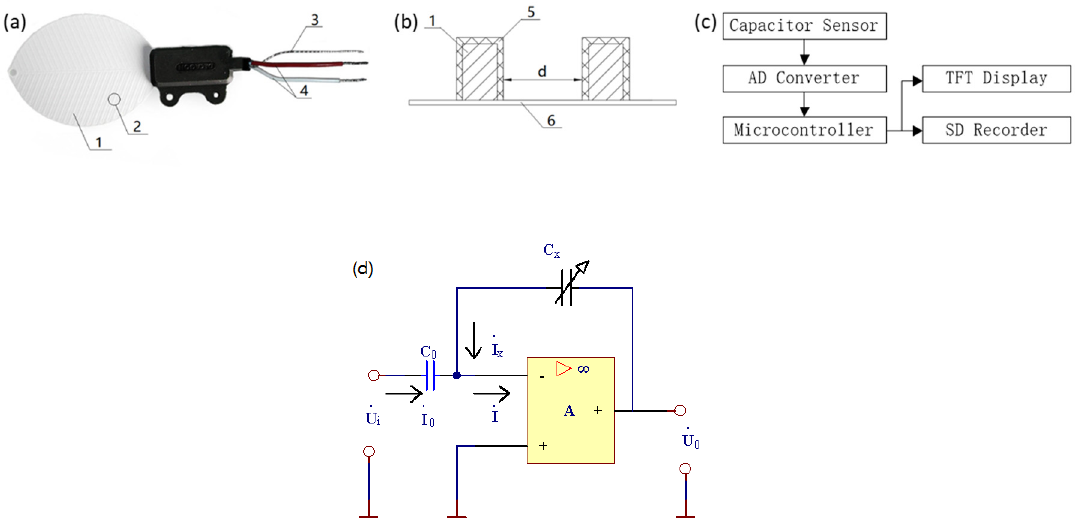
Figure 1. The structure of the leaf-like capacitor sensor and the deposit monitoring system. ( a ) Is the leaf-like sensor. ( b ) Is the electrode structure on the resin board. ( c ) Is the implementation diagram of the deposit monitoring system. ( d ) Is an electric schematic of the circuit of the leaf like sensor. 1 = electrodes, 2 = capacitor, 3 = data cable, 4 = power cable, 5 = insulating coating, 6 = resin board. The sensor is in 11.2 cm of length, 5.8 cm of width and 0.075 cm of thickness. The distance between each electrode is 1.58–1.78 mm. The width of the electrode is 0.59–0.79 mm and the thickness is 0.01-0.02 mm. The thickness of the insulating layer is about 2 μ m. In ( d ), C 0 is a fixed capacitor, C x is the leaf like sensor.